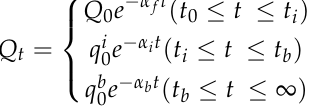
Figure 10. The conduit pattern (curvilinear branchwork) used in scenario C. ( a ) Model runs only under diffuse recharge. ( b ) In addition to the diffuse recharge, two different point recharge modes are also applied to the model. The purple squares represent the location of point recharge as sinkholes. Other conduit patterns (rectilinear branchwork and network maze) in scenario C can be found in the Supplementary Materials (Figure S3).